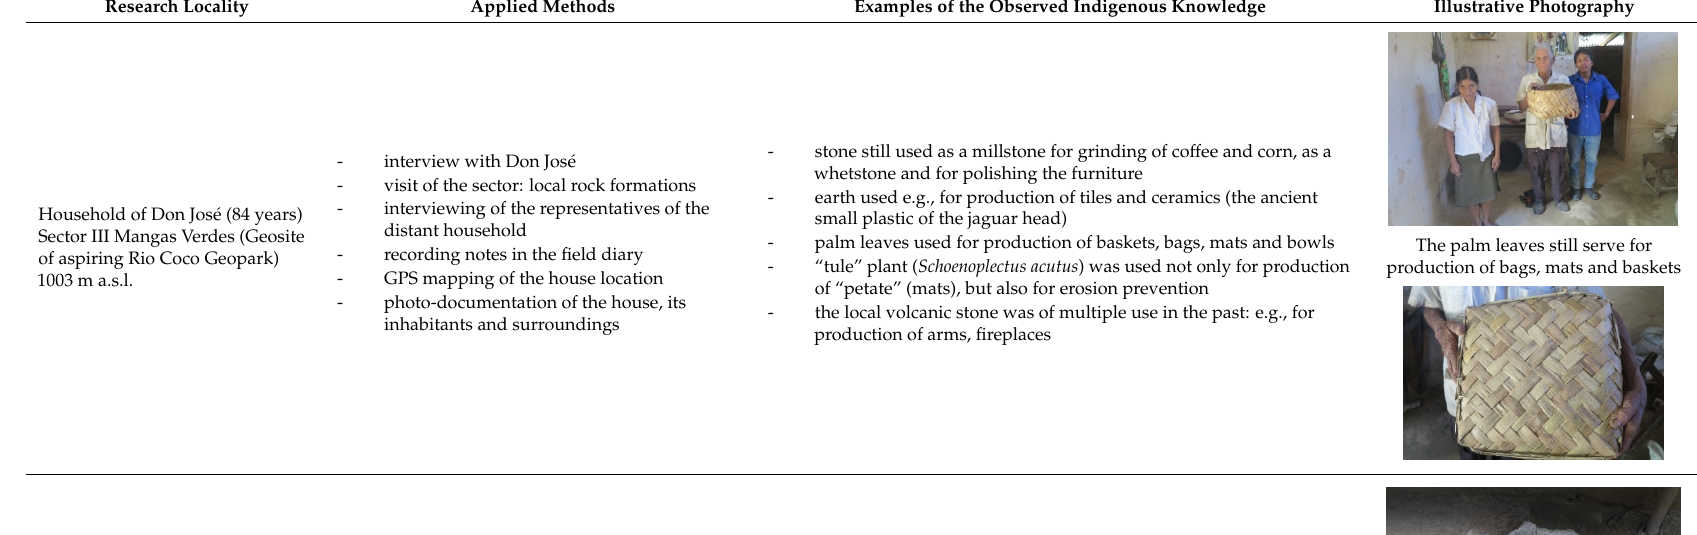
15 of 25 Eroded volcanic stone used as a manager Eroded volcanic stone used as a manager for domestic animals and “ladrillos” prepared for burning